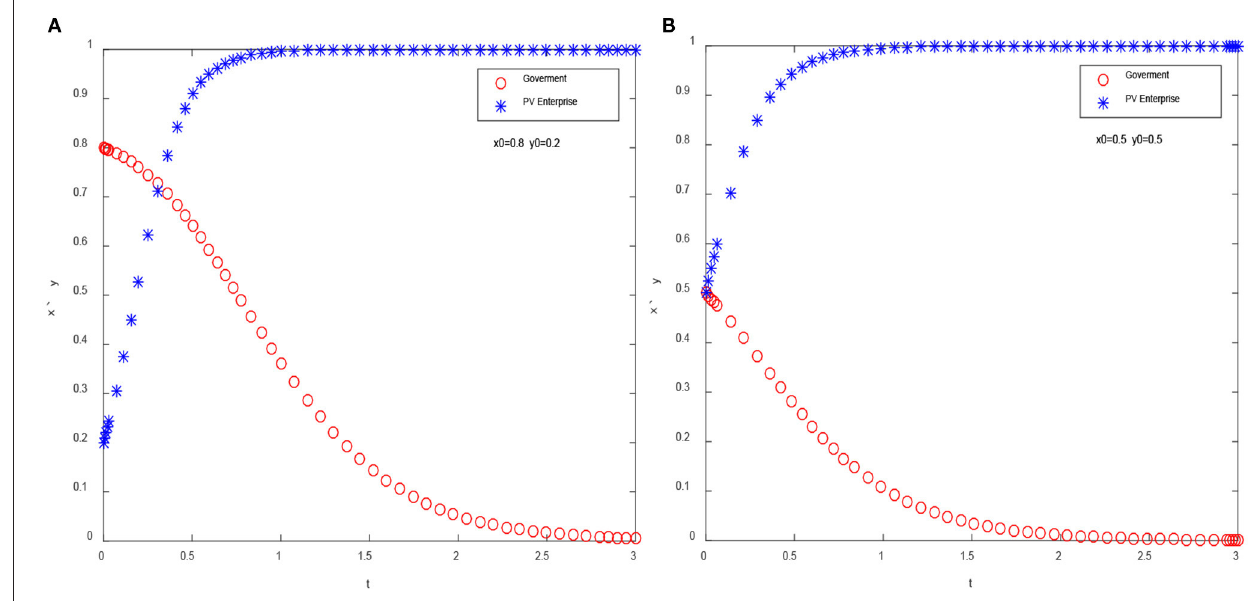
FIGURE 6 | Evolution path of dual participant system. (A) Initial state: x = 0.8, y = 0.2 and (B) Initial state: x = 0.5, y =